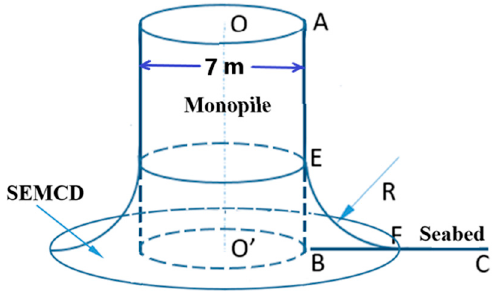
Figure 2. Design of the surface profile of the SEMCD.